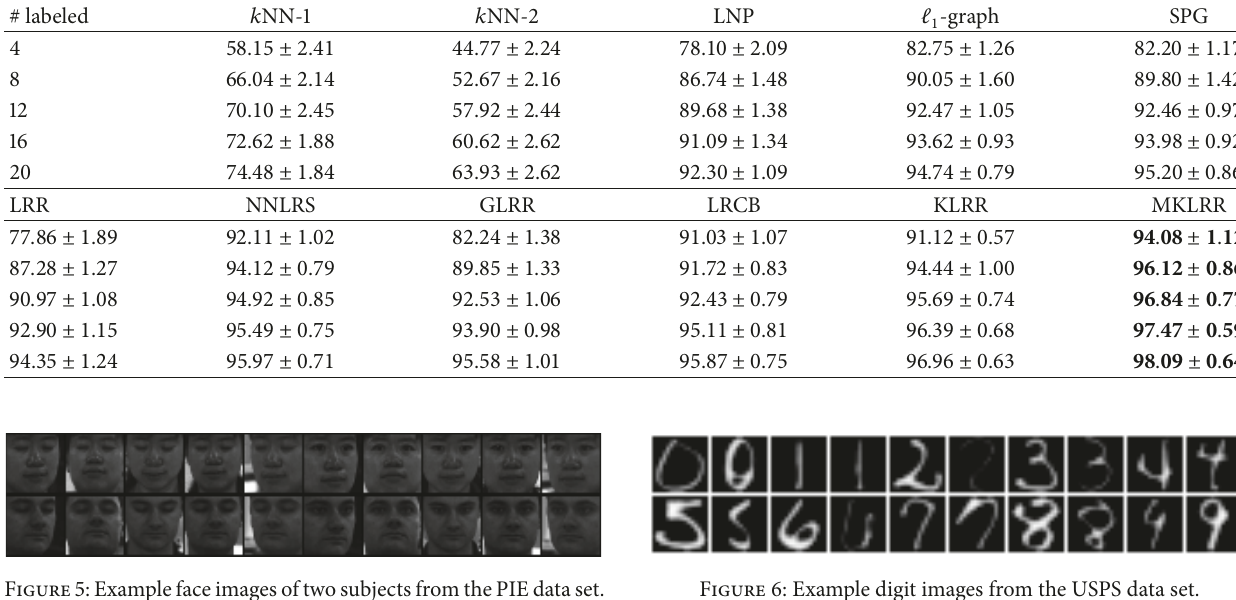
shows the classification accuracies of different algorithms with different numbers of labeled samples on the PIE data